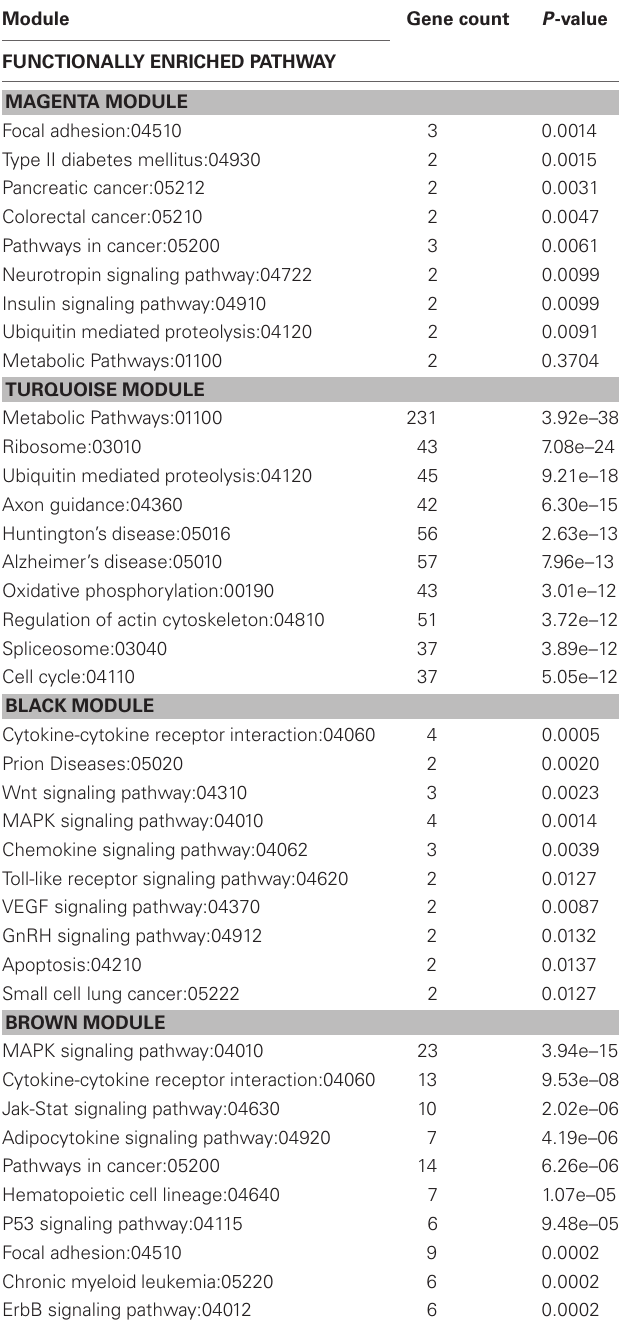
Table 5 | KEGG functionally enriched pathway categories generated from modules of genes correlated to exercise and/or stress.